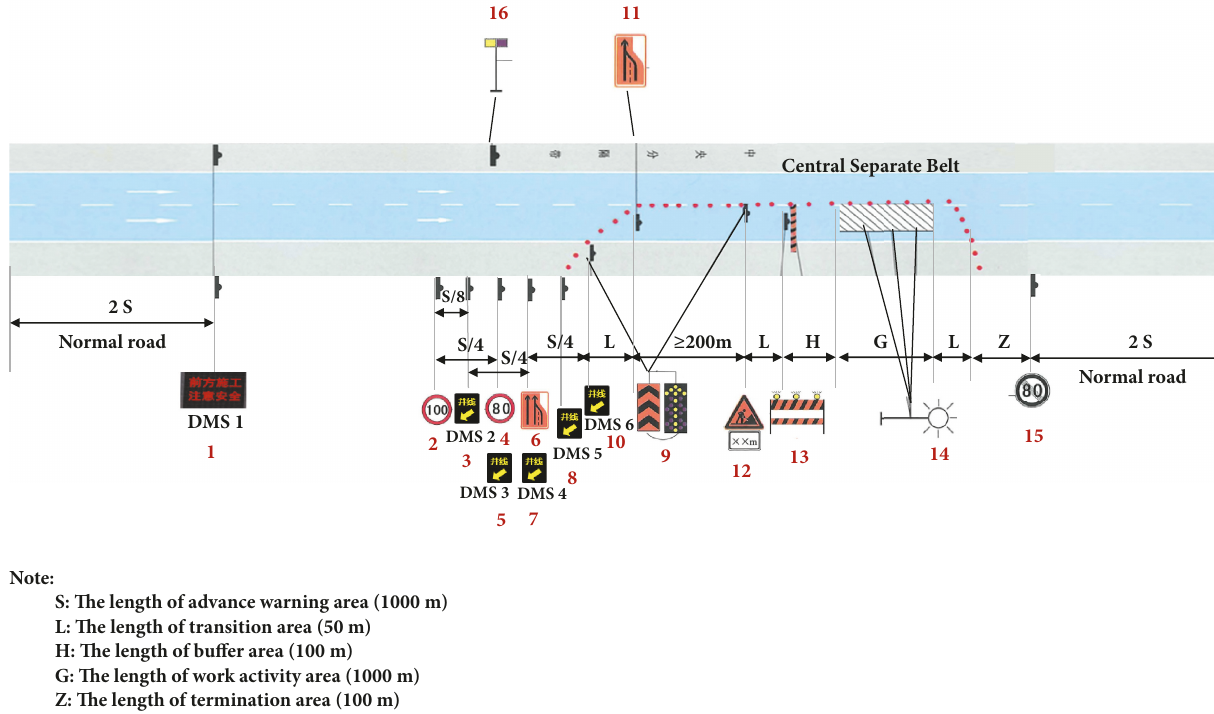
Figure 3: Standard layout and longitudinal cross-sectional structures of a work zone featuring the closure of the right lane.